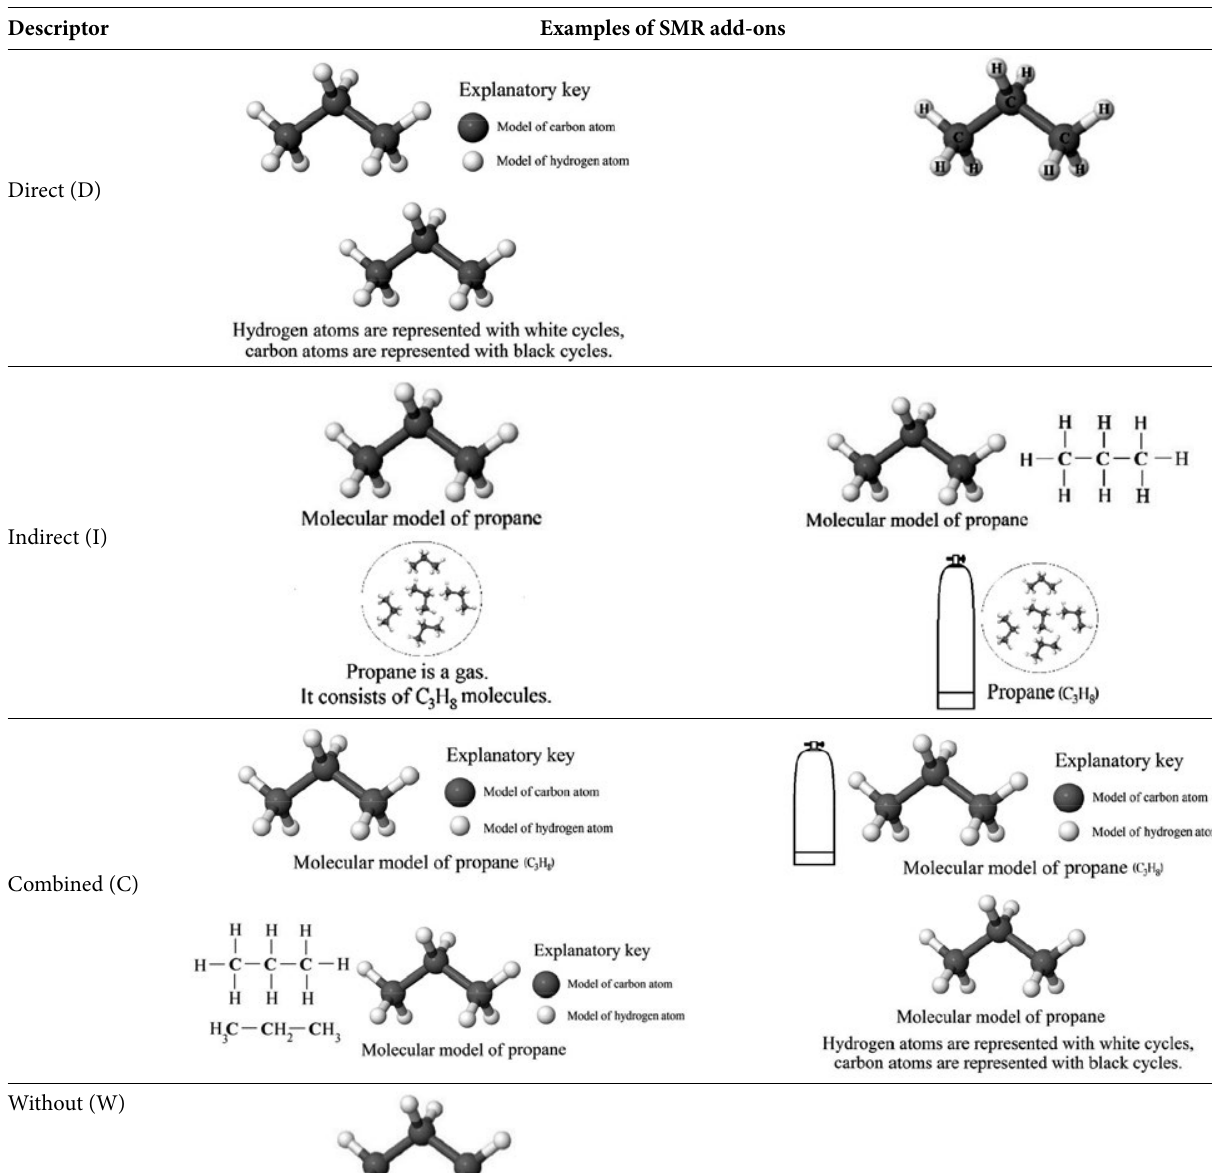
Table 2. Examples of SMR